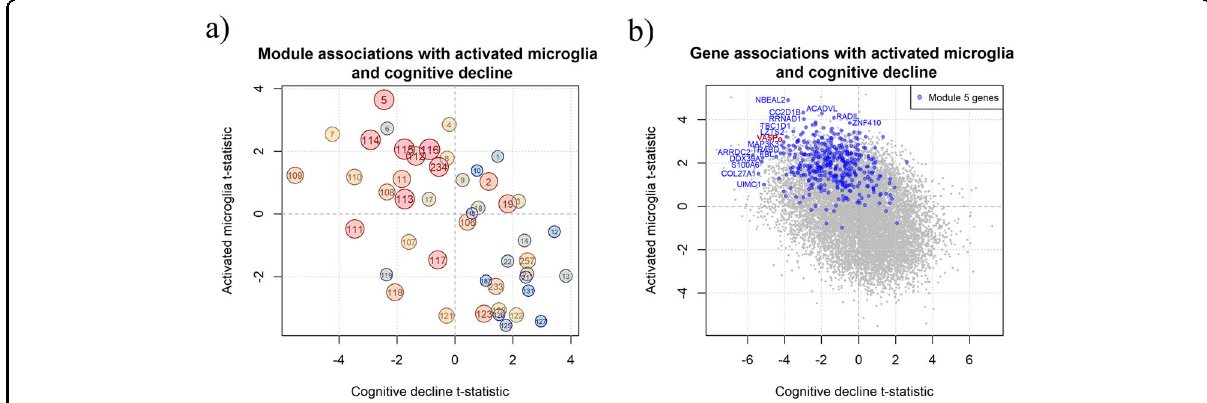
Fig. 3 Association of genes and modules with microglia morphology. a Scatter plot displaying on the Y axis, the t-statistics for associations between module expression in our DLPFC bulk RNA-seq data and the proportion of activated (stage III) microglia and on the X axis t-statistics for module expression and cognitive decline. Each circle represents one module, and the number of the module is listed in each circle. m5 is the module most positively associated with the number of stage III microglia. To illustrate the extent of a module ’ s enrichment for the HuMiAged microglia signature genes, we have both colored the modules (red being more enriched, blue less enriched) and made the size of the circle proportional to the enrichment (the larger circles such as m116 are more enriched for microglial genes). The t-statistics are derived from linear models adjusted for age, sex, study (ROS or MAP), RNA integrity number (RIN), and postmortem interval. b Scatter plot displaying on the Y axis, the t-statistics for the association of a gene ’ s expression level and the proportion of activated (stage III) microglia and on the X axis t-statistics for the association of the gene ’ s expression level and cognitive decline. A subset of genes in module 5 which has extreme results are labeled. All genes belonging to module 5 are in blue with VASP highlighted in red. The t-statistics are derived from linear models adjusted for age, sex, study (ROS or MAP), RIN, and postmortem